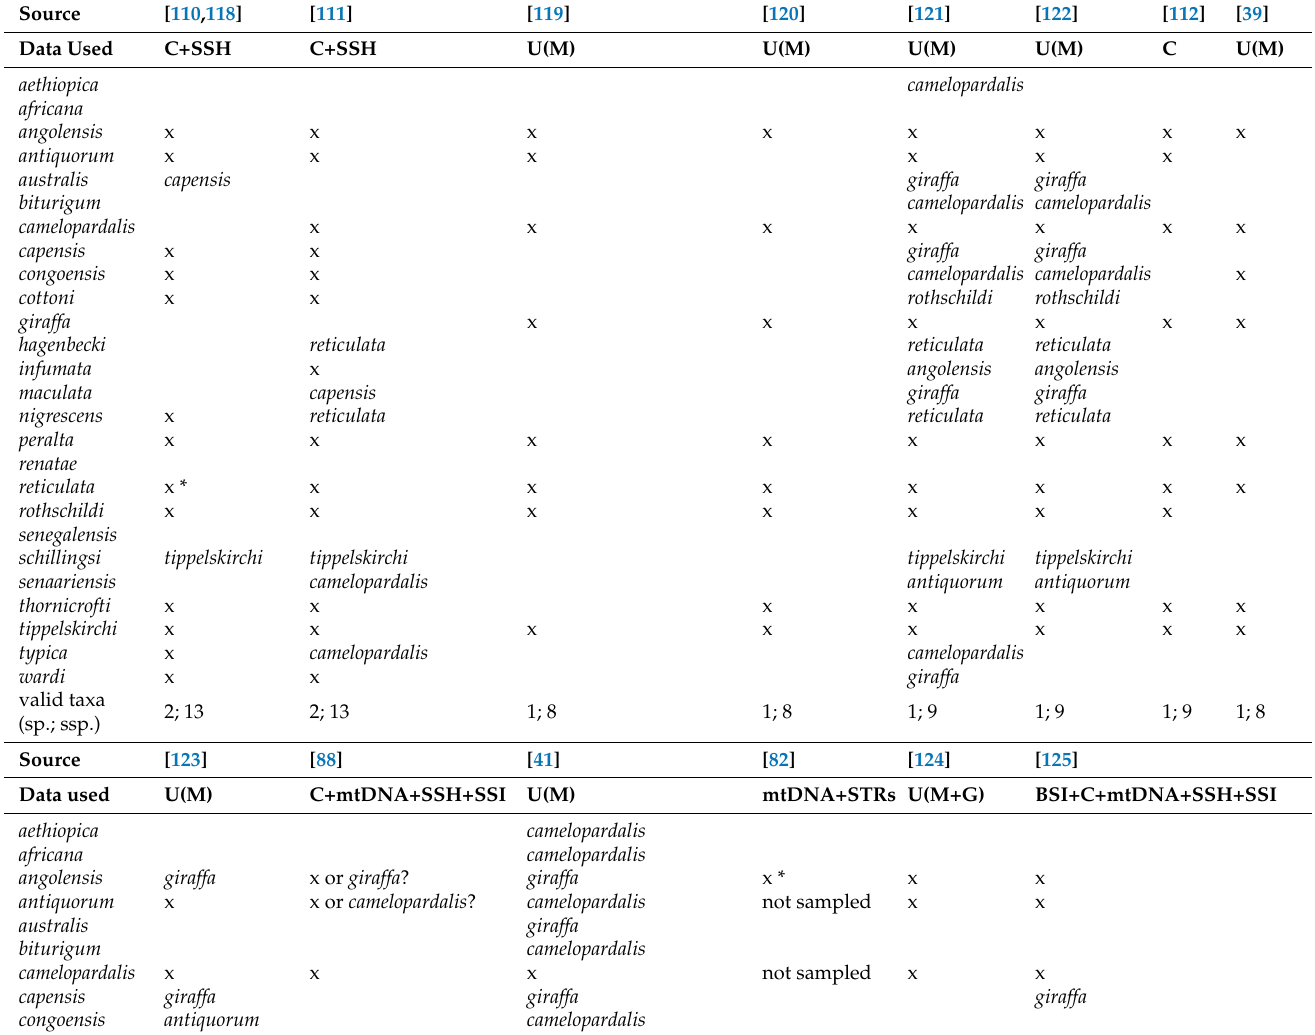
Table 2. Giraffe taxa recognized in the 20th and 21st centuries across several basic sources, which seemed to assess giraffes independently and/or using different